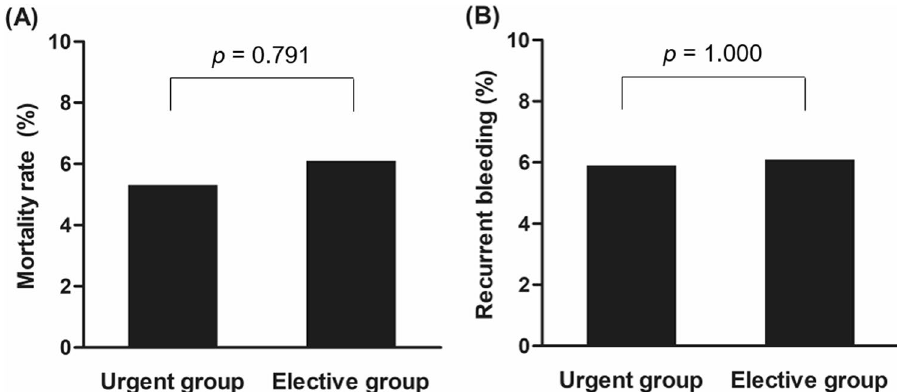
Figure 2. Mortality and recurrent bleeding rates within 30 days. ( A ) The mortality rate did not differ between the urgent (≤ 6 h from presentation) and elective (> 6 h from presentation) endoscopy groups, ( B ) the recurrent bleeding rate did not differ between the groups.